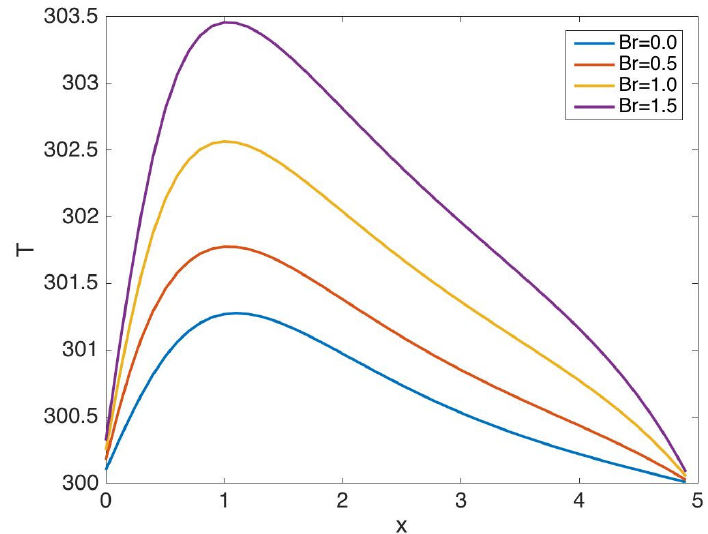
Figure 5. Temperature profiles against x -axis at y = 1 m, for various values of Br of Case 1.